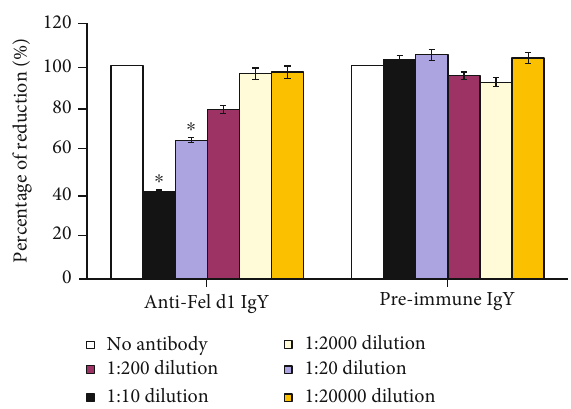
Figure 5: Beta-hexosaminidase release assay with chicken egg anti- Fel d1 antibodies compared to egg IgY antibodies from nonimmunized chickens. The anti-Fel d1 IgY antibody dose- dependently reduced mediator release in the rat basophil assay compared to a “ no-antibody ” control while preimmune IgY had no e ff ect. ∗ Signi fi cantly di ff erent from control ( p < 0 : 001